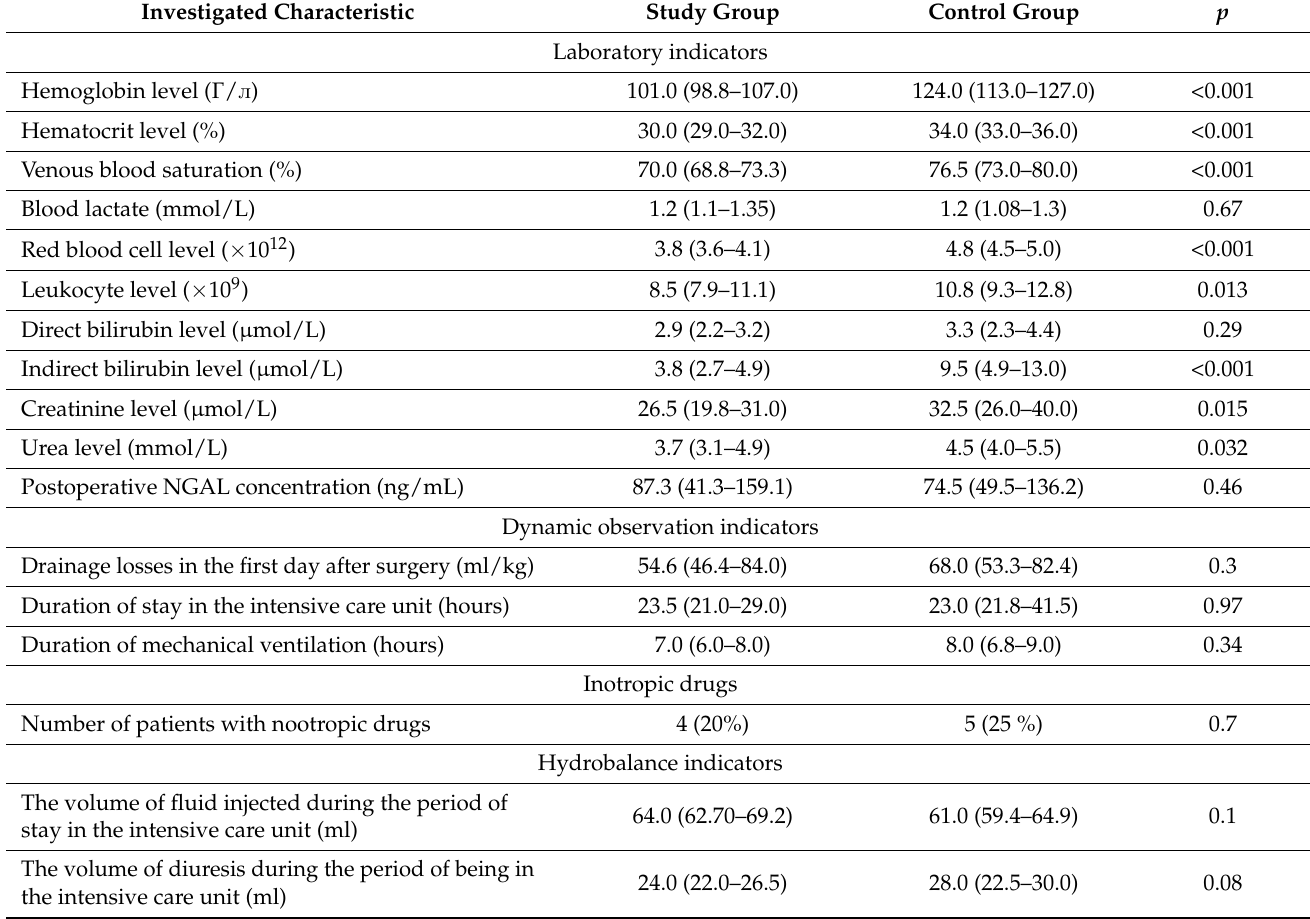
Table 3. Characteristics of the factors of the postoperative